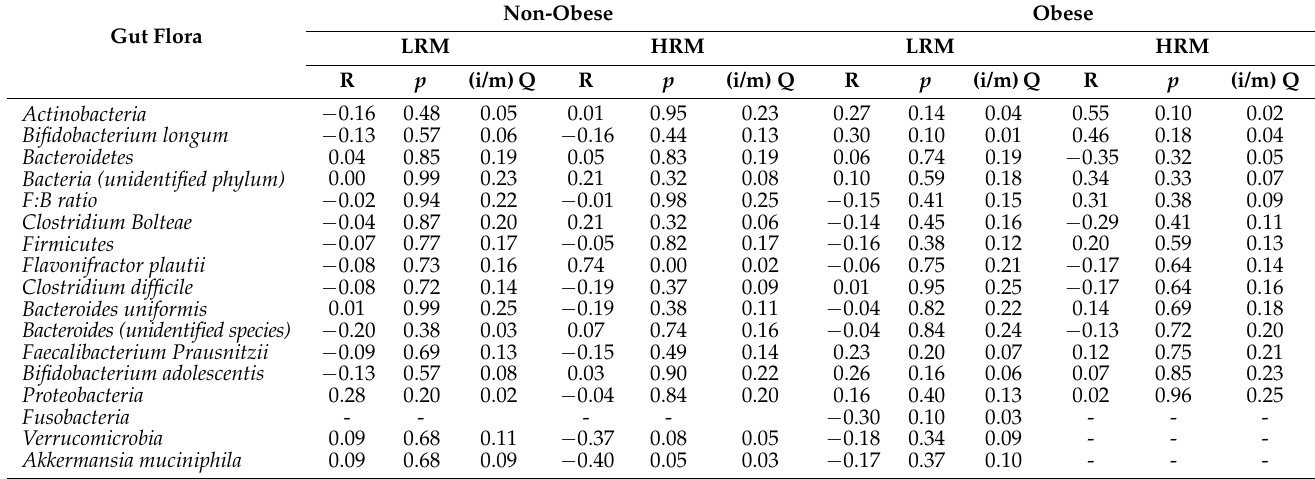
1 Data are presented as Pearson correlation coefficients adjusted for age. F:B: Firmicutes to Bacteroidetes; HRM: high red meat intake; (i/m) Q: Benjamini-Hochberg critical value for a false discovery rate of 0.25; LRM: low red meat intake. High red meat intake is > 11 g/1000 kcal for the obese group, low red meat intake is ≤ 11 g/1000 kcal for the obese group, high red meat intake is > 16 g/1000 kcal for the non-obese group, and low red meat intake is ≤ 16 g/1000 kcal for the non-obese group. The hyphens in cells indicate that gut flora is not present in these categories or that the number of observations for this group is not high enough to report a correlation